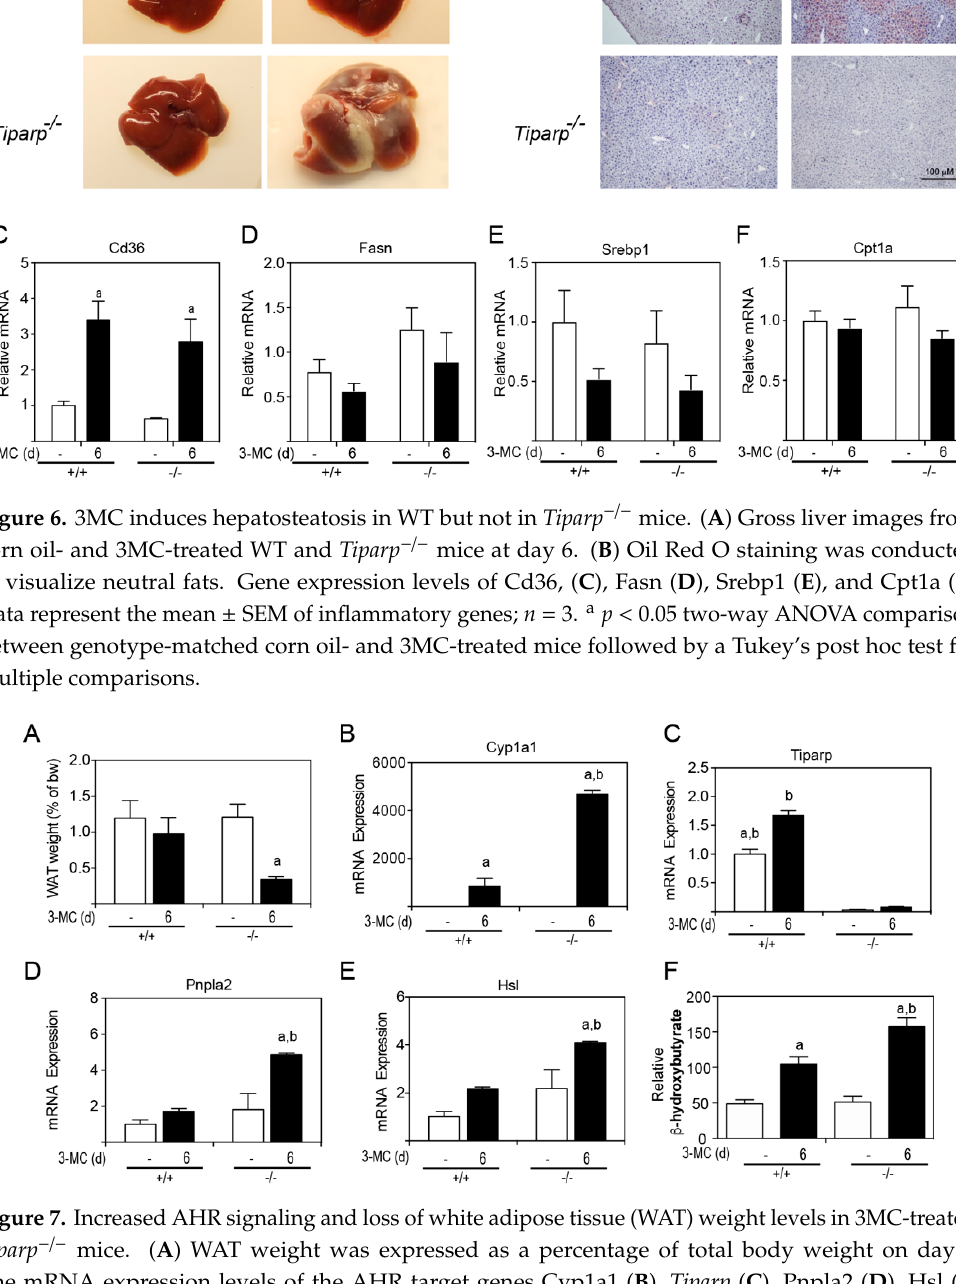
Figure 7. Increased AHR signaling and loss of white adipose tissue (WAT) weight levels in 3MC-treated Tiparp − / − mice. ( A ) WAT weight was expressed as a percentage of total body weight on day 6. The mRNA expression levels of the AHR target genes Cyp1a1 ( B ), Tiparp ( C ), Pnpla2 ( D ), Hsl ( E ) and serum β -hydroxybutyrate (F) were measured. Data represent the mean ± SEM; with an n = 3 ( A ). a p < 0.05 two-way ANOVA comparison between genotype-matched corn oil- and 3MC-treated mice followed by a Tukey’s post hoc test for multiple comparisons and b p < 0.05 two-way ANOVA comparison between treatment-matched WT and Tiparp − / − mice followed by a Tukey’s post hoc test.